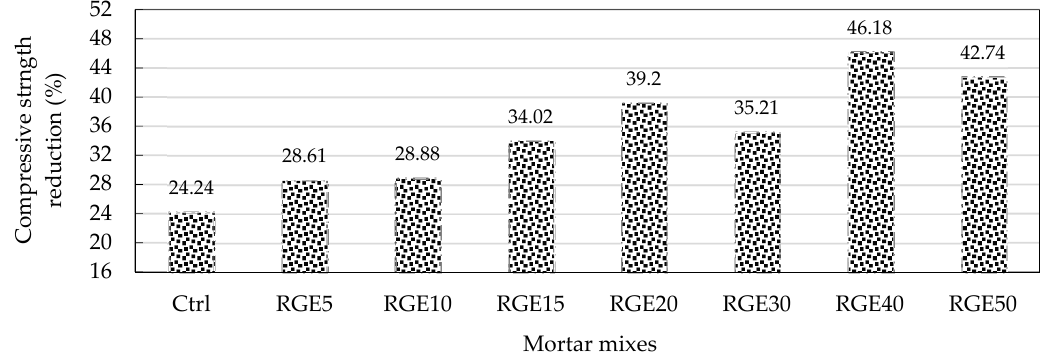
Figure 17. Compressive strength reduction percentage at 120 days (20% sodium sulphate).